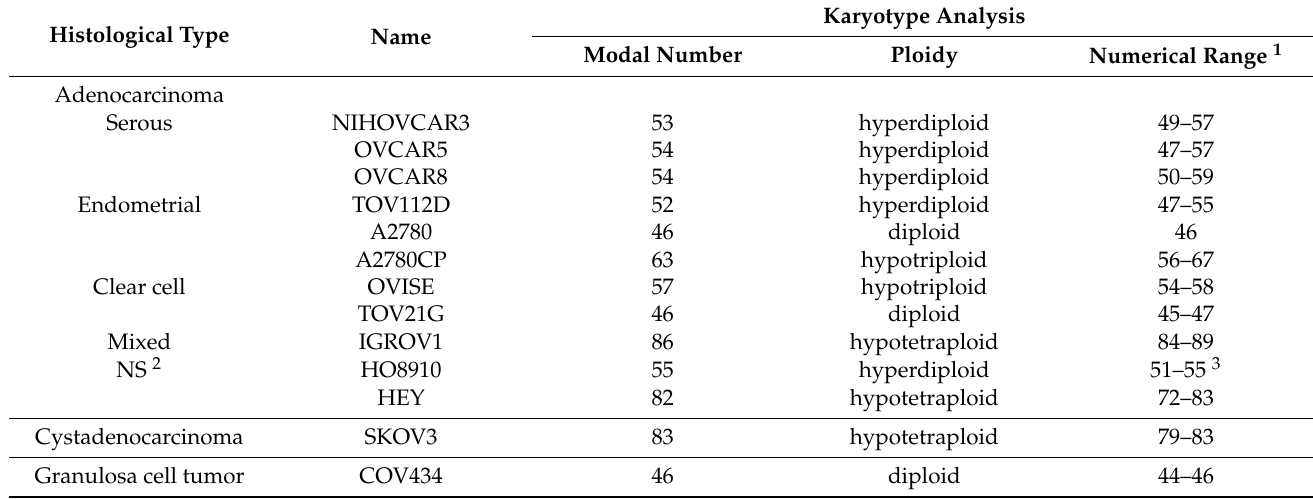
Table 1. Karyotype analysis of 13 commonly used ovarian cancer cell lines.